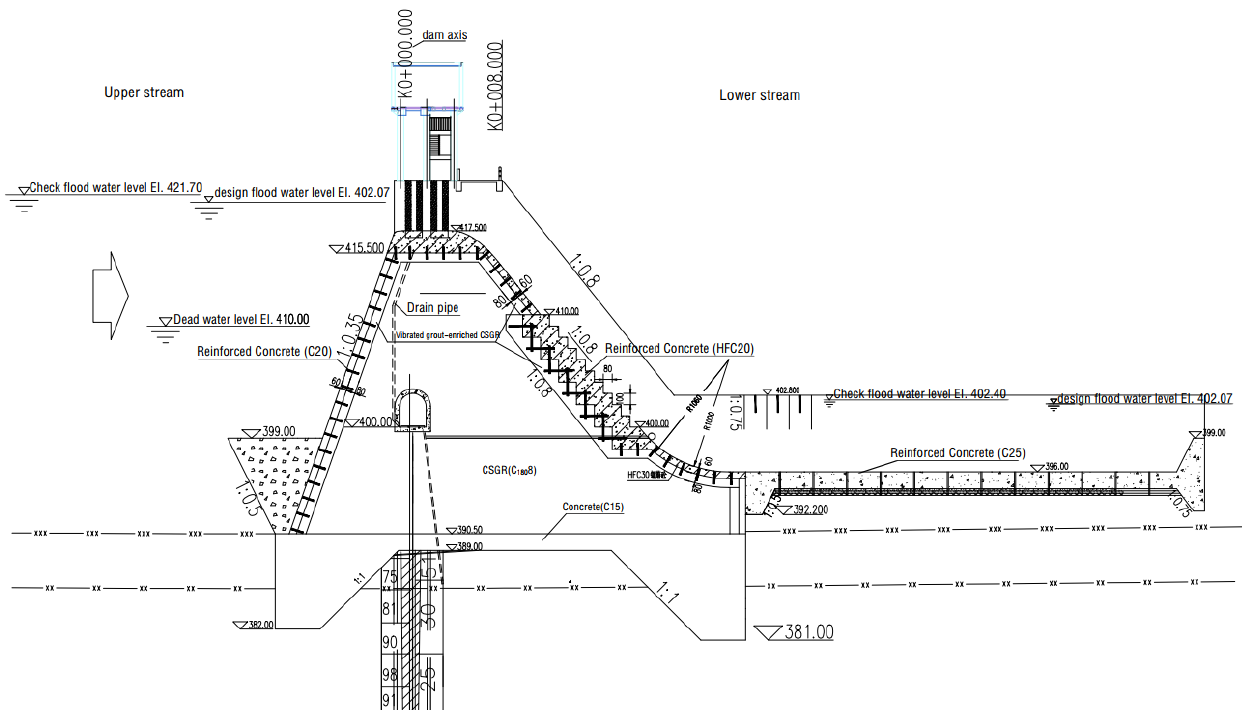
Figure 1. Typical design cross-section of a cemented soft rock dam. Table 1. Main strength test results of cemented sand and gravel with different types of